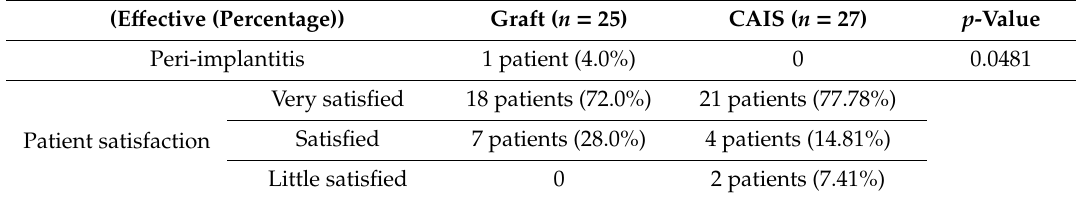
Table 7. The first year of